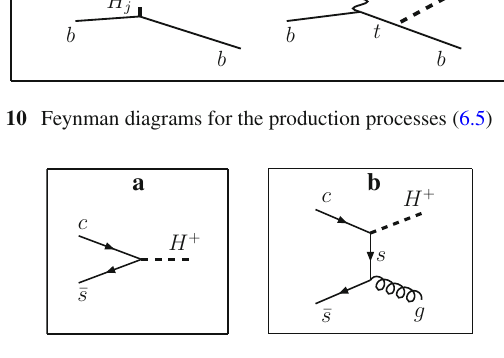
Fig. 11 Feynman diagrams for the production processes (6.6)